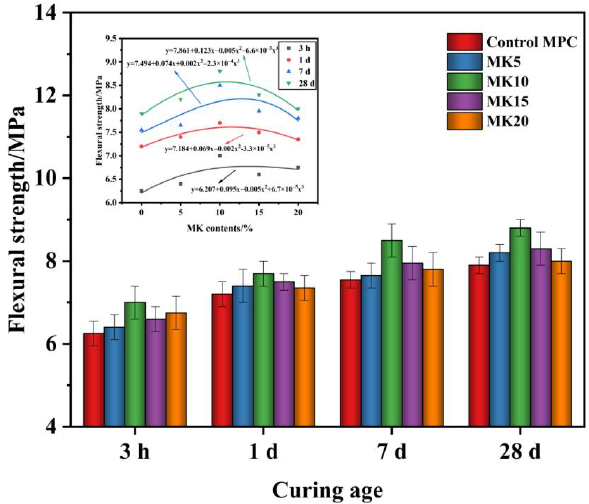
Figure 14. The effect of MK content on MPC flexural strength.